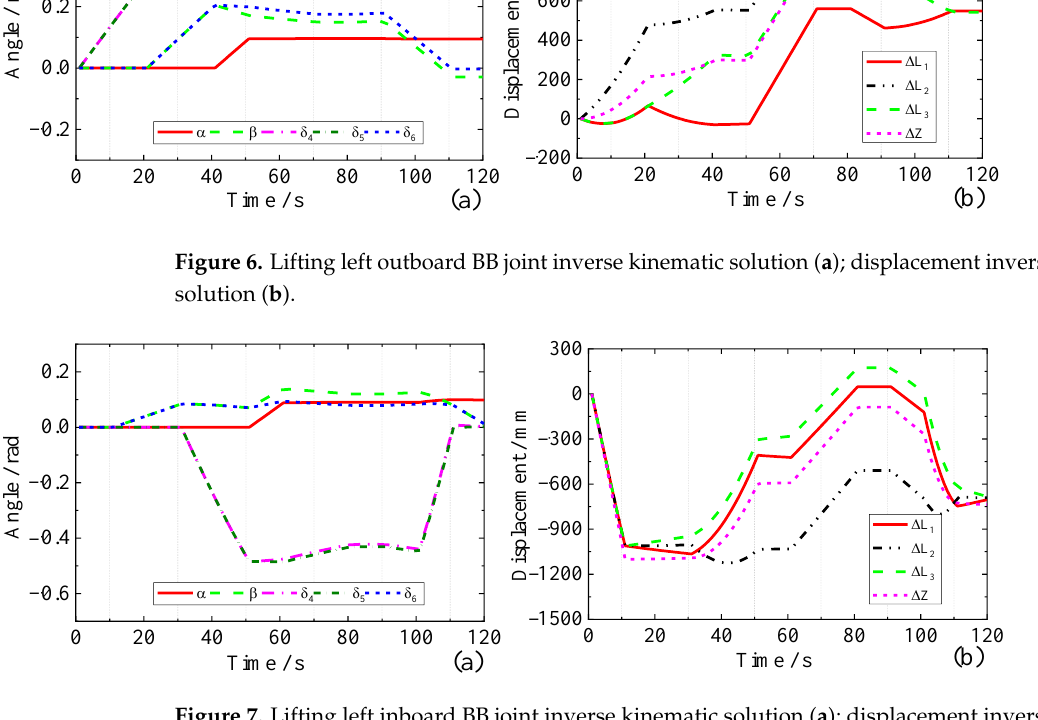
Figure 7. Lifting left inboard BB joint inverse kinematic solution ( a ); displacement inverse kinematic solution ( b ).